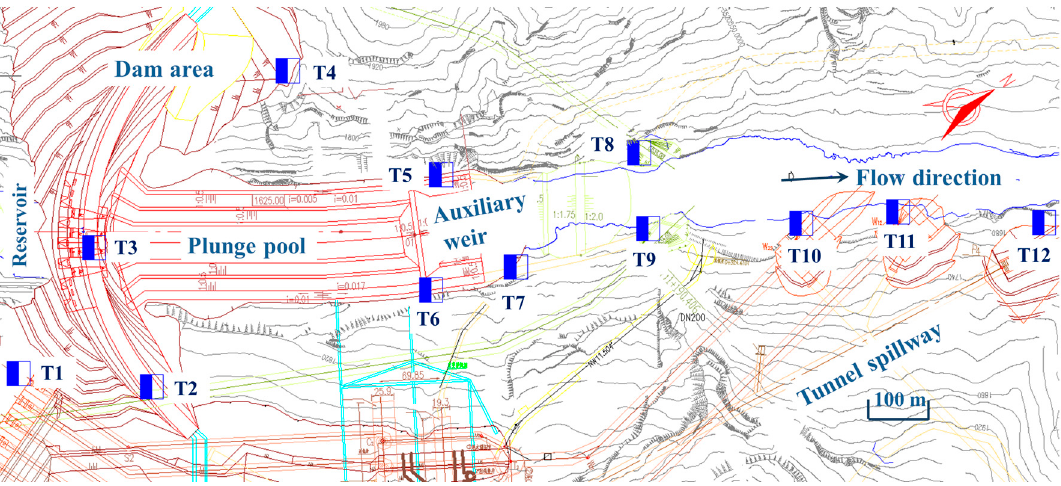
Figure 1. Observation points arrangement of LFN.